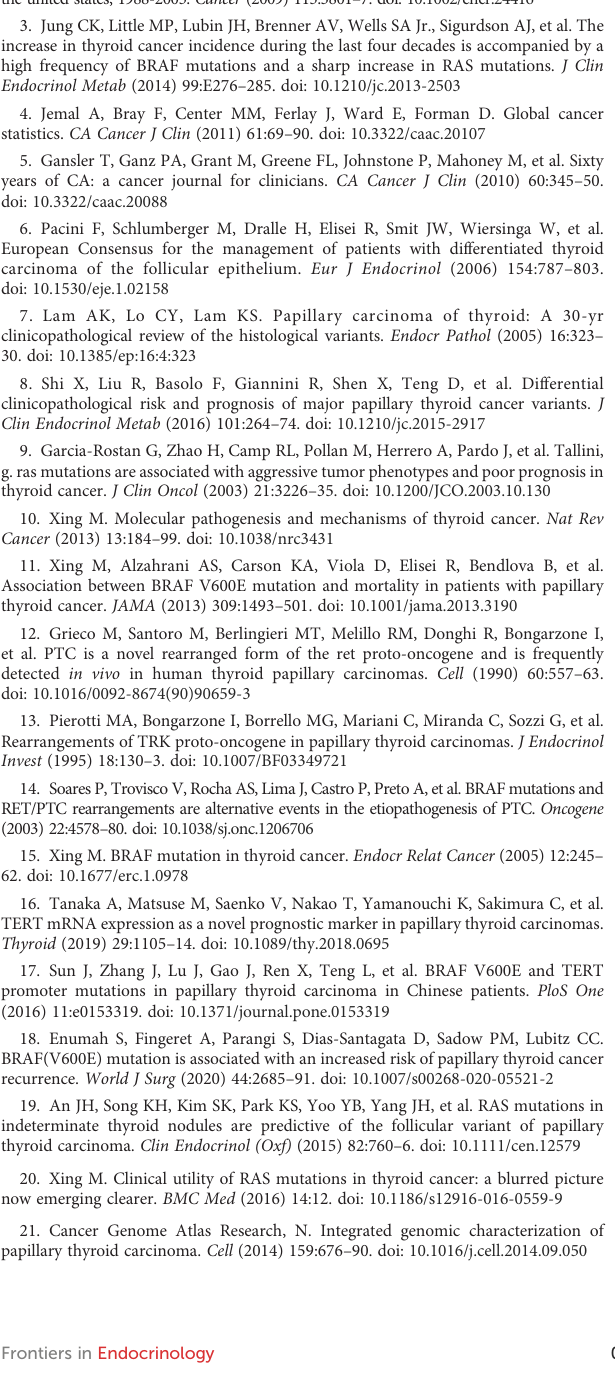
SUPPLEMENTARY FIGURE 3 The delicate papillae result from cellular dehiscence, with rugged surface and adhesion. SUPPLEMENTARY FIGURE 4 Putative scheme of papillae formations. (A) The delicate papillae originate from packed microfollicles. (B) The common papillae originate from irregular